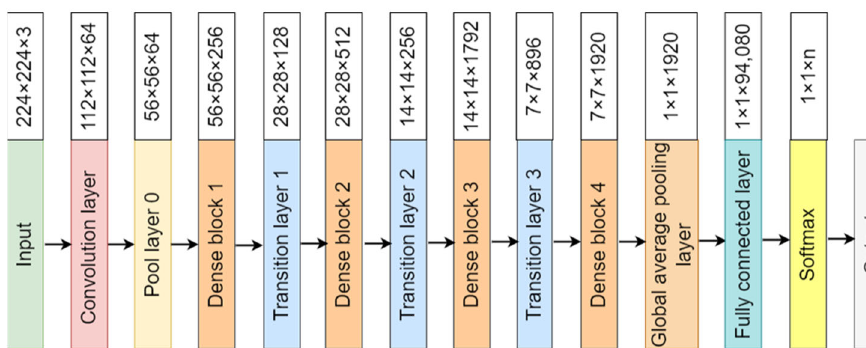
Figure 9. Densenet201 architecture.